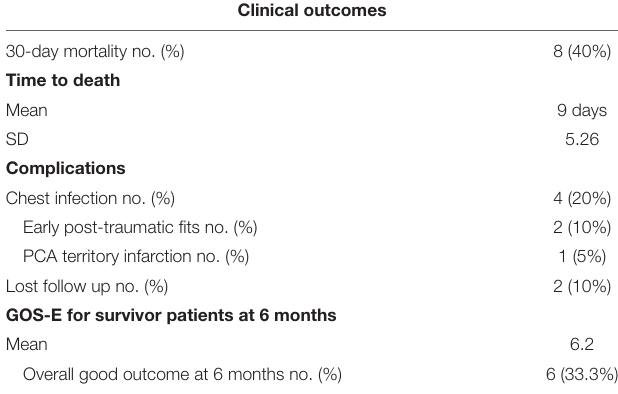
TABLE 4 | Clinical